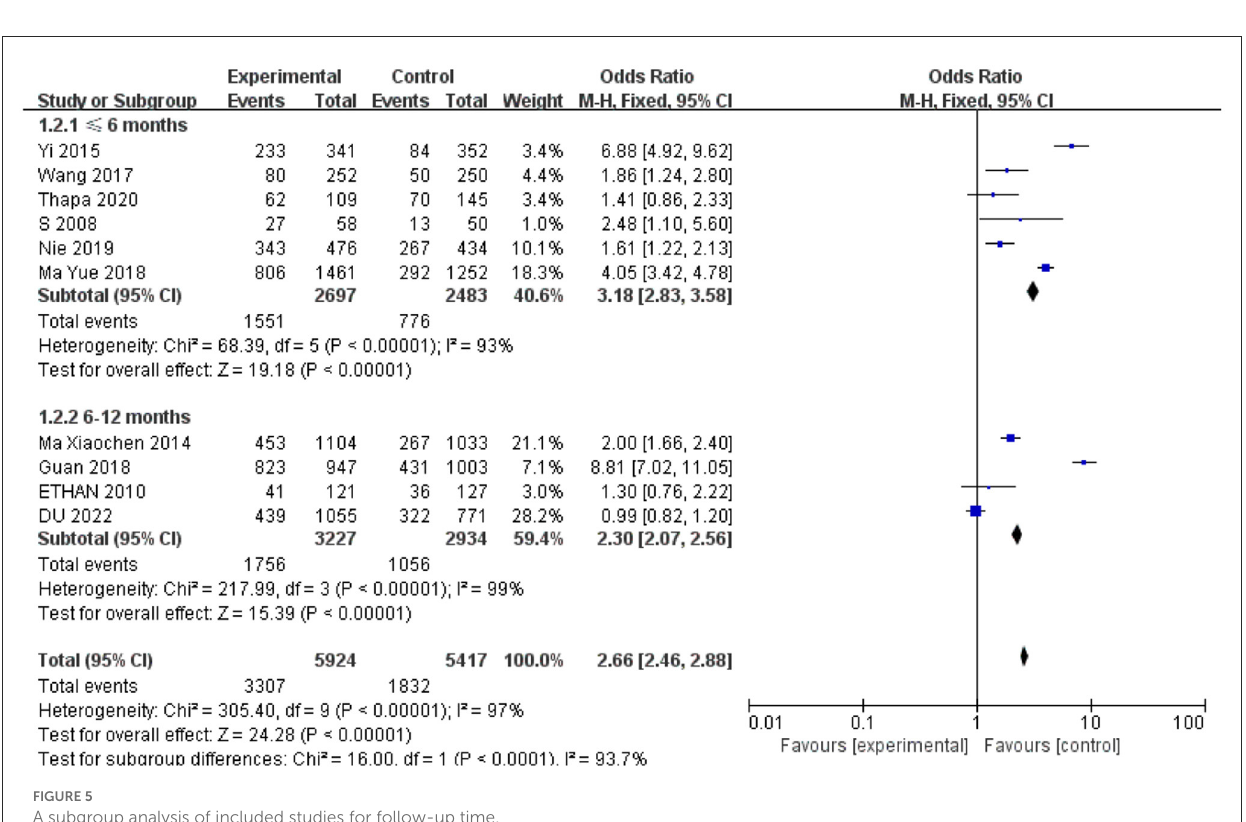
FIGURE5 A subgroup analysis of included studies for follow-up